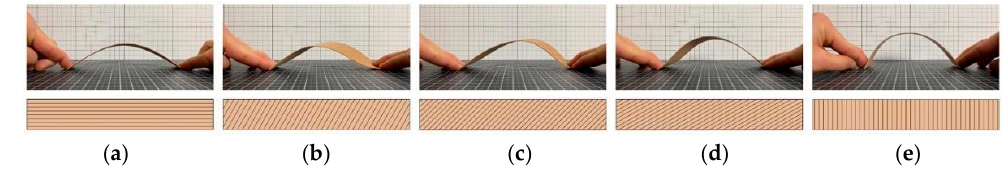
Figure 4. Bending studies with varied grain direction of thin timber veneer: ( a ) 0-degree primary grain direction; ( b ) 30 degrees; ( c ) 45 degrees; ( d ) 60 degrees; ( e ) 90 degrees.